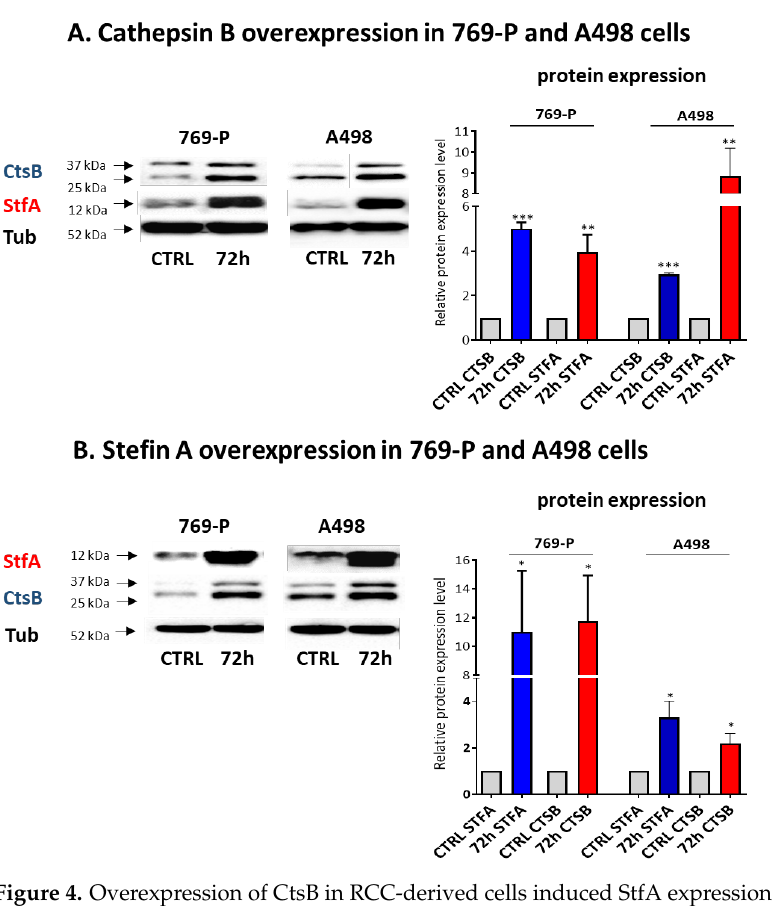
Figure 4. Overexpression of CtsB in RCC-derived cells induced StfA expression and vice versa. CtsB and StfA protein expression was determined by Western blotting in 769-P and A498 after transfection with ( A ) pl CTSB and ( B ) pl STFA . * = p < 0.05, ** = p < 0.01, *** = p < 0.001.